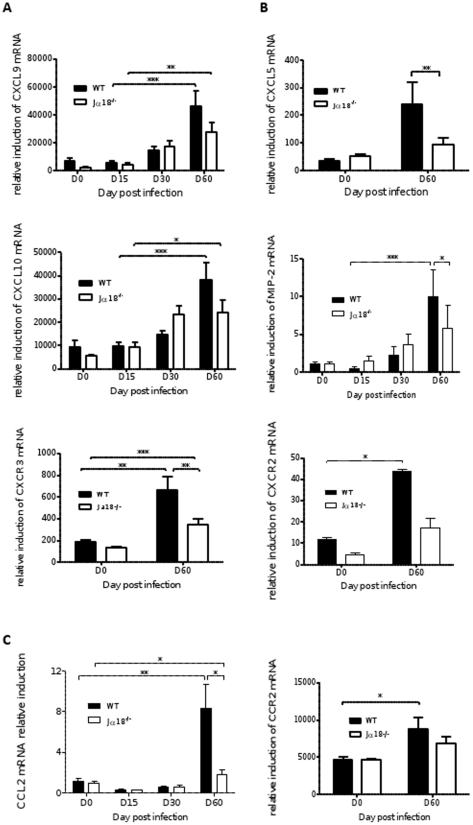
Kinetics of selected chemokine and related chemokine receptors expression in liver extracts from WT and Jα18-/- mice.mRNA expression of selected chemokines and their receptors was quantified by qPCR in liver extracts at various time points after infection. Quantification of mRNA for the T and NK cell-chemoattractant chemokines CXCL9, CXCL10 and their receptor CXCR3 (A), quantification of the PMN-chemoattractant chemokines MIP-2 and CXCL5 and their receptor CXCR2 (B) and of CCL2 and its receptor CCR2 (C). Data are the mean±SEM of 8 to 10 mice per group from two independent experiments and normalized on the expression of three housekeeping genes.